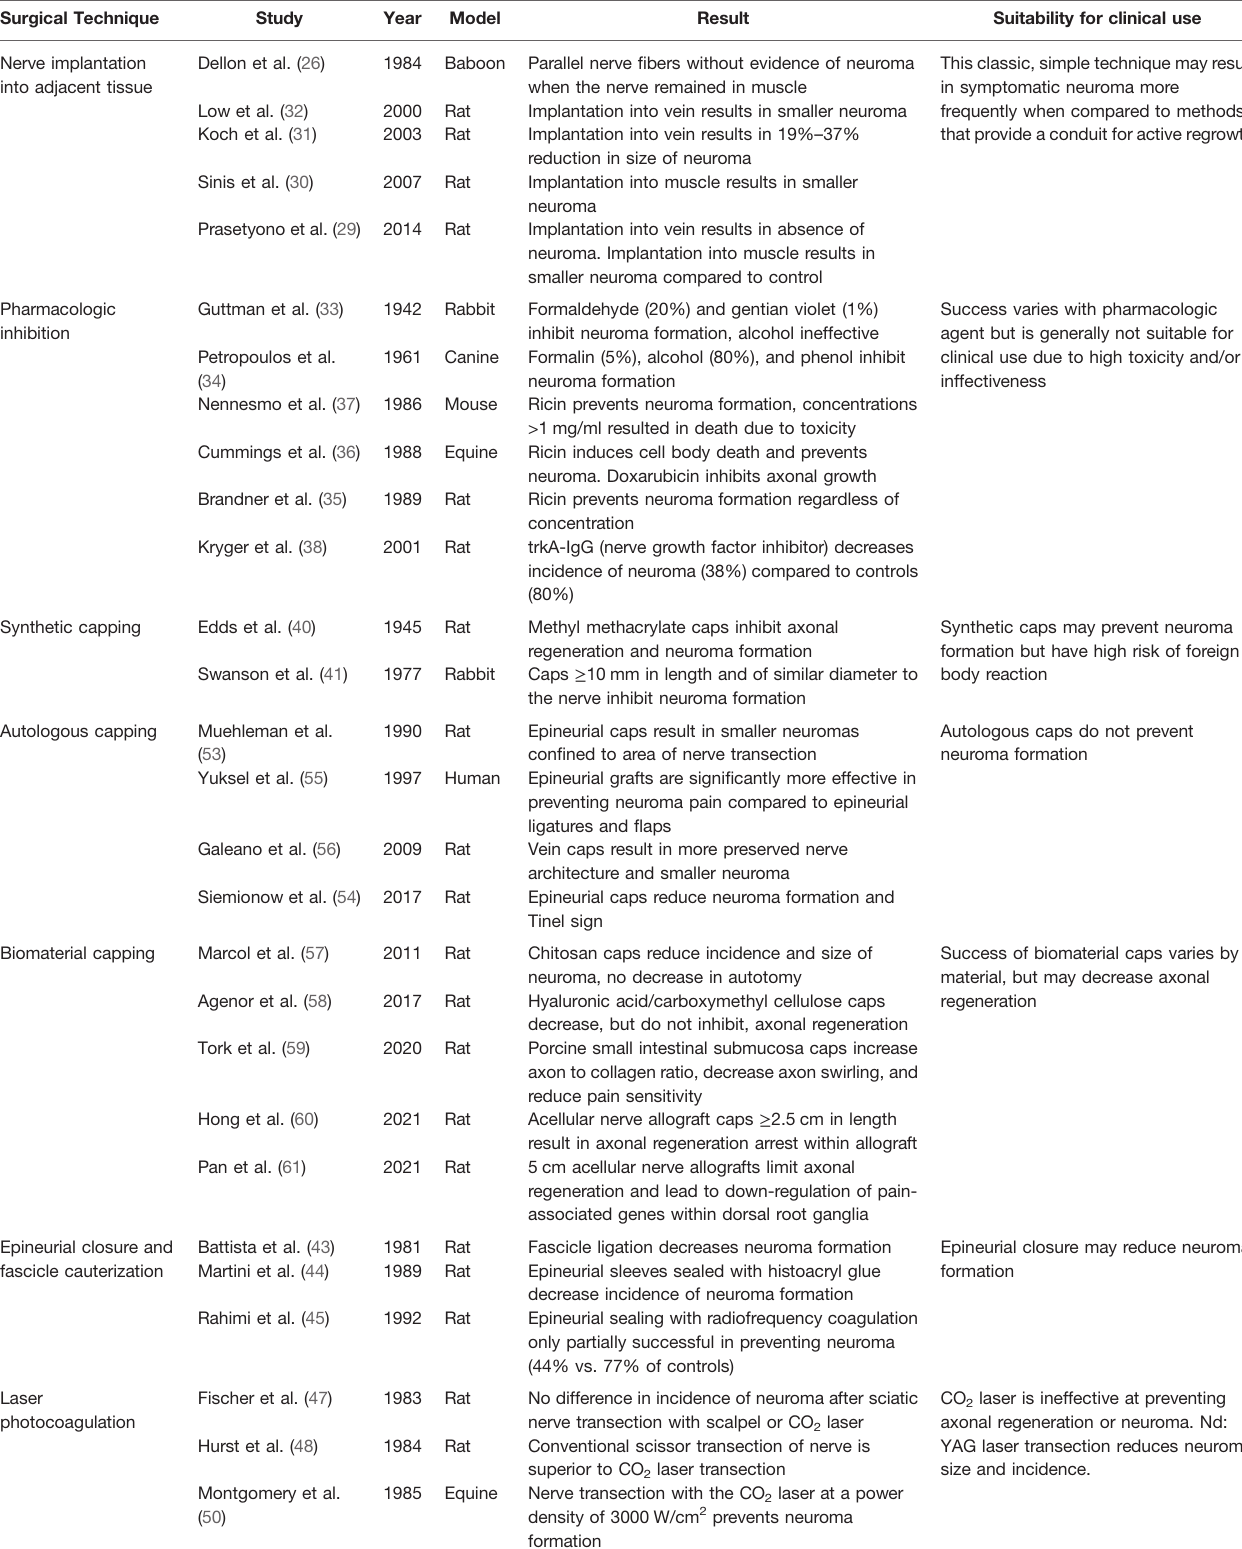
TABLE 1 | Comprehensive literature review table summarizing surgical technique, author, year of publication, model of study, result, and suitability for clinical use. Surgical